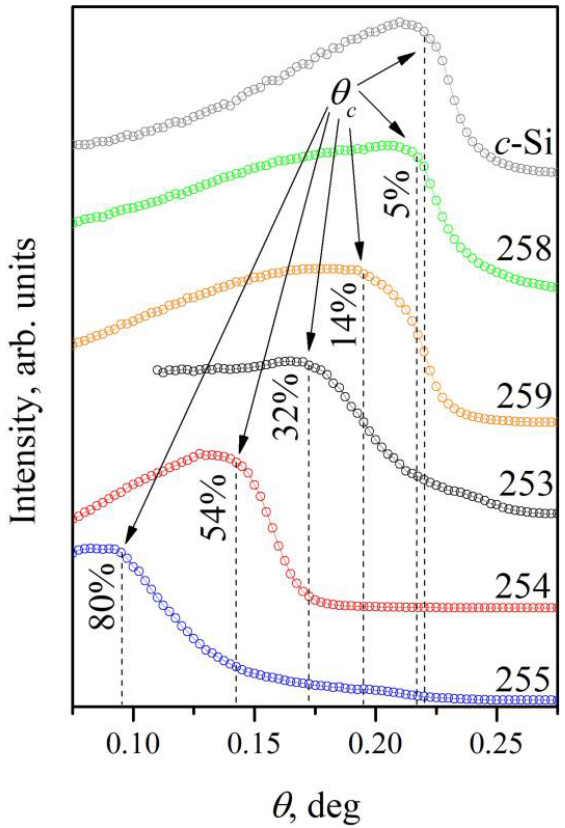
Figure 1. XRR curves and the calculated porosity indexes for the samples of porous silicon. The dashed lines show the values of critical angles corresponding to the total external reflection θ c-PS .